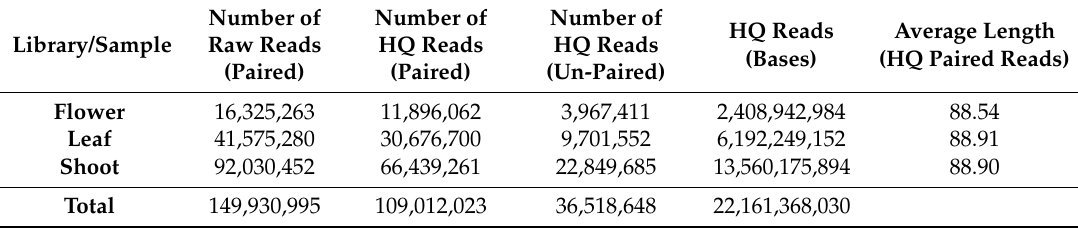
Table 1. Summary of the trimming results with Trimmomatic for each cDNA library sequenced.